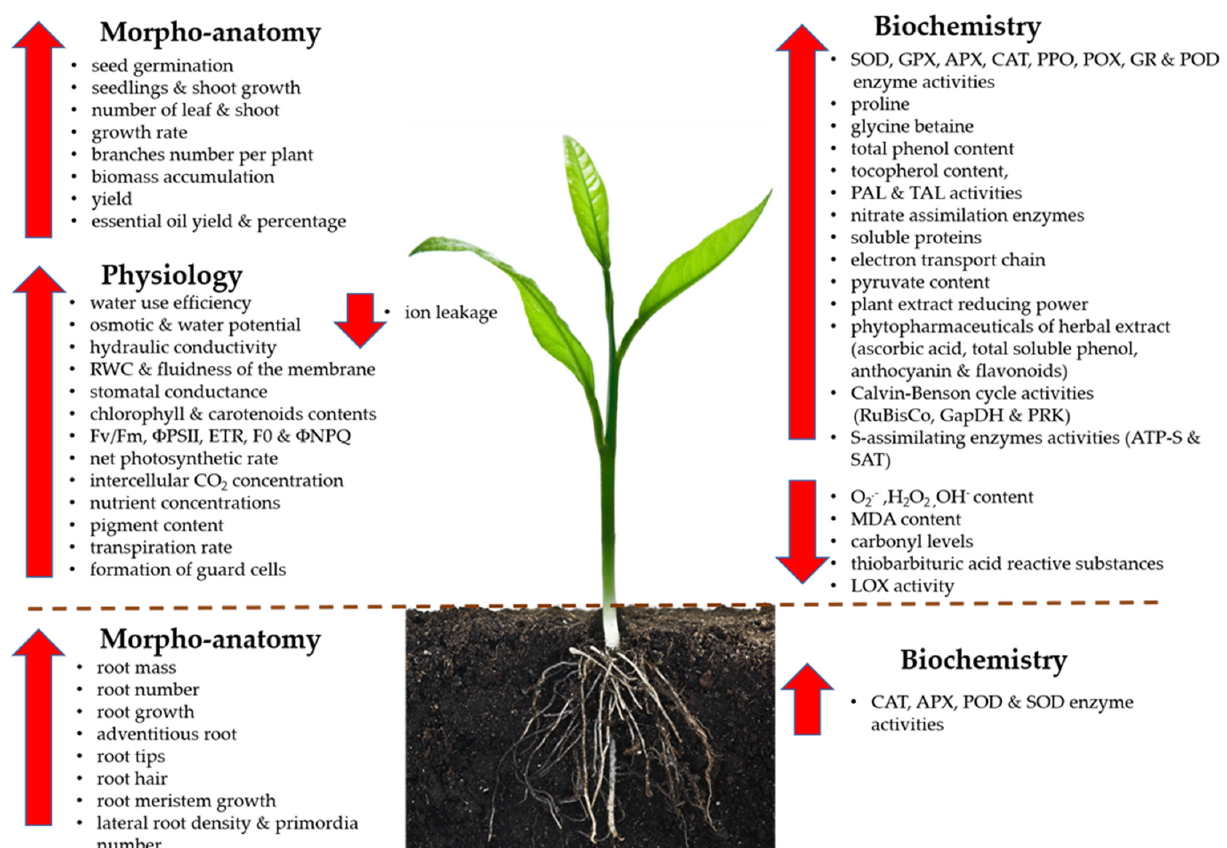
Figure 5. Overview of nitric oxide (NO) roles in alleviating drought stress at morpho-anatomical, physiological and biochemical levels in leaves and roots of a plant. Φ PSII, photosystem II; Φ NPQ, quantum yield of regulated energy dissipation; APX, ascorbate peroxidase; ATP-S, ATP-sulfurylase; CAT, catalase; ETR, electron transport rate; Fv/Fm, photochemical efficiency of photosystem Ⅱ; GAPDH, glyceraldehyde-3-phosphate dehydrogenase; GPX, glutathione peroxidase; GR, glutathione reductase; H 2 O 2 , hydrogen peroxide; LOX, lipoxygenase; POD and POX, peroxidases; PPO, polyphenol oxidase; O 2• − , superoxide anion; O 2 , oxygen; OH - , hydroxyl radical; PAL, phenylalanine ammonia-lyase; PRK, phosphoribulokinase; RuBisCo, ribulose 1,5-bisphosphate carboxylase/oxygenase; SAT, serine acetyltransferase; SOD, superoxide dismutase; TAL, tyrosine ammonia-lyase.